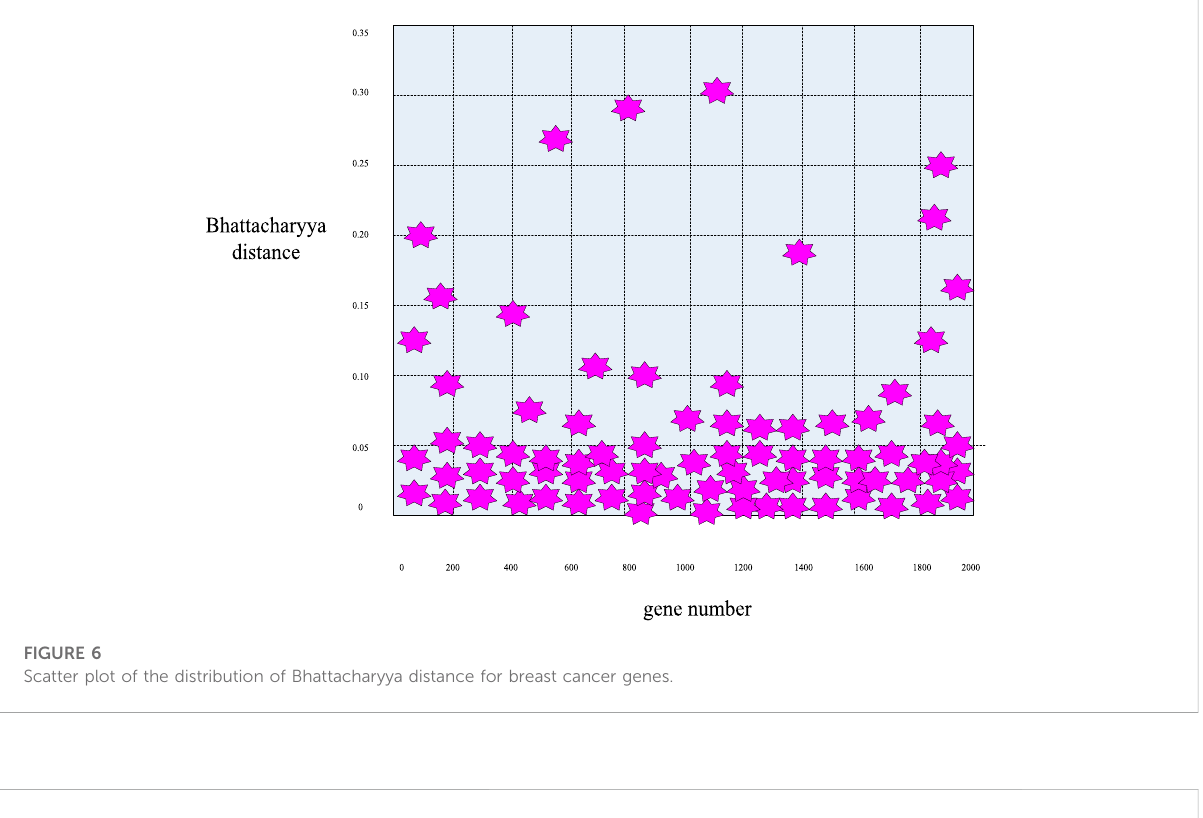
FIGURE 6 Scatter plot of the distribution of Bhattacharyya distance for breast cancer genes.